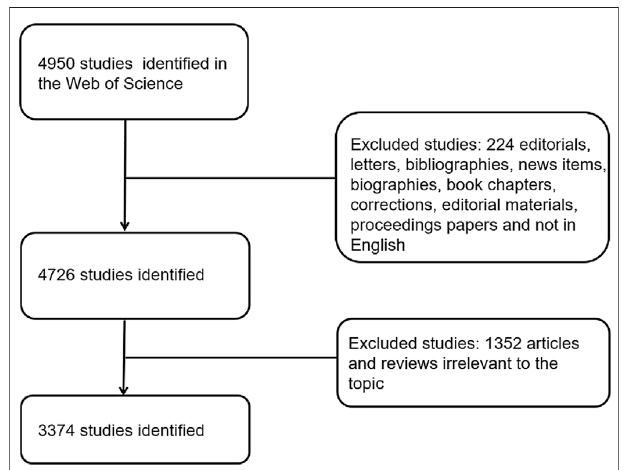
FIGURE2| Flowdiagram oftheinclusionprocess.Thedetailedprocess of screening and enrolment (irrelevant articles were manually screened by two authors through abstracts and full texts), and articles irrelevant to the topic were